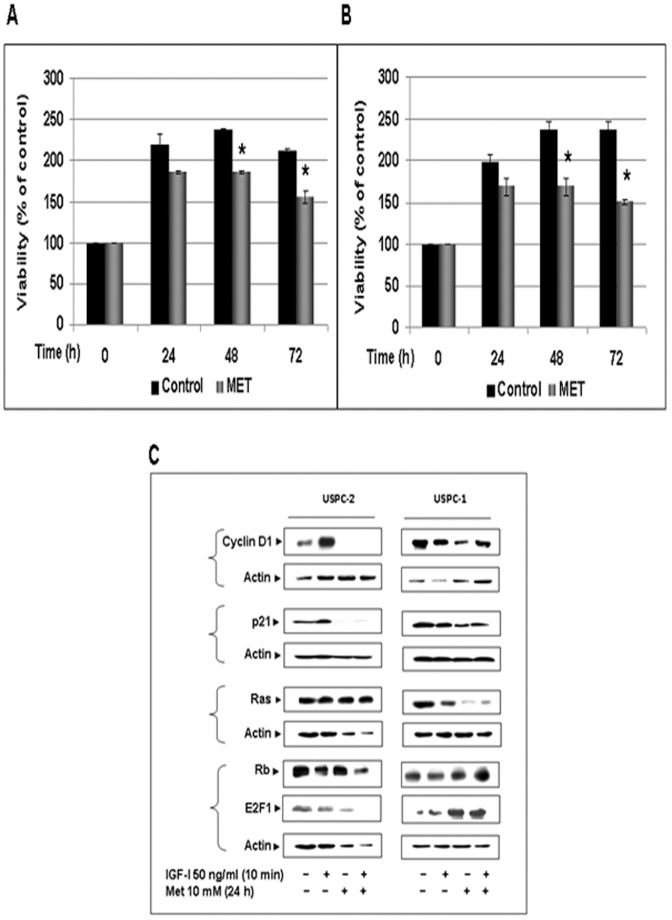
Effect of metformin on proliferation and cell cycle regulatory proteins in USC cells.Cells were plated in 24-well plates at a density of 5×104 cells/well for USPC-2 (A) and 3.6×104 cells/well for USPC-1 (B). Cells were incubated in the absence (open bars) or presence (solid bars) of metformin, and proliferation was evaluated at 24, 48 and 72 h by MTT measurements. A value of 100% was given to the cell number at time 0. The bars represent the mean ± S.E.M. of three independent experiments, performed each in triplicate samples; *p<0.05 versus untreated cells. C, Western blot analysis of cyclin D1, p21, Ras, Rb and E2F1 in USPC-2 and USPC-1 cells treated with metformin for 24 h in the absence or presence of IGF-I. Whole-cell lysates (100 µg) were resolved by SDS-PAGE and immunoblotted with the indicated antibodies. Results are representative of three independent experiments.